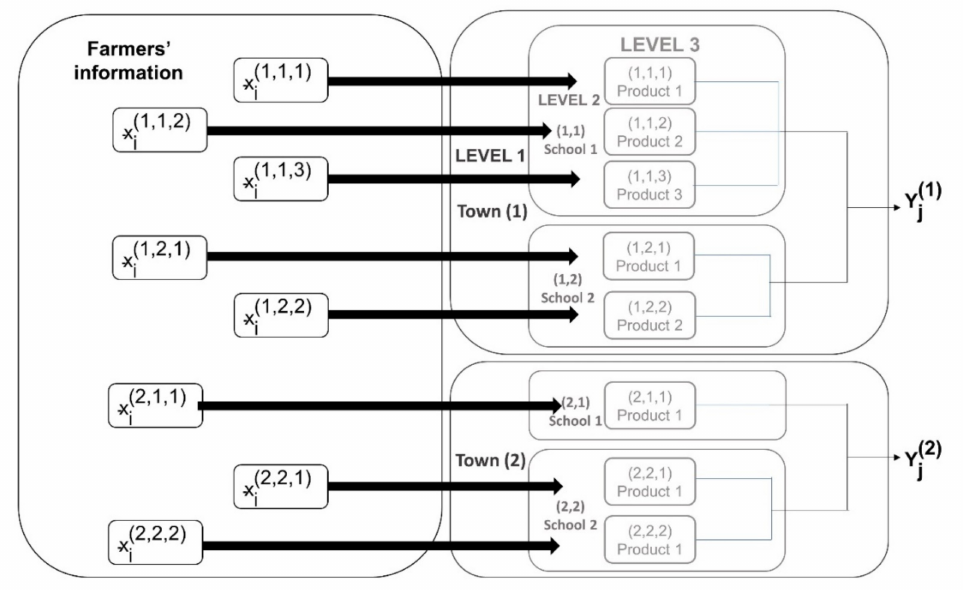
Figure 3. Bid/No-Bid hierarchical network